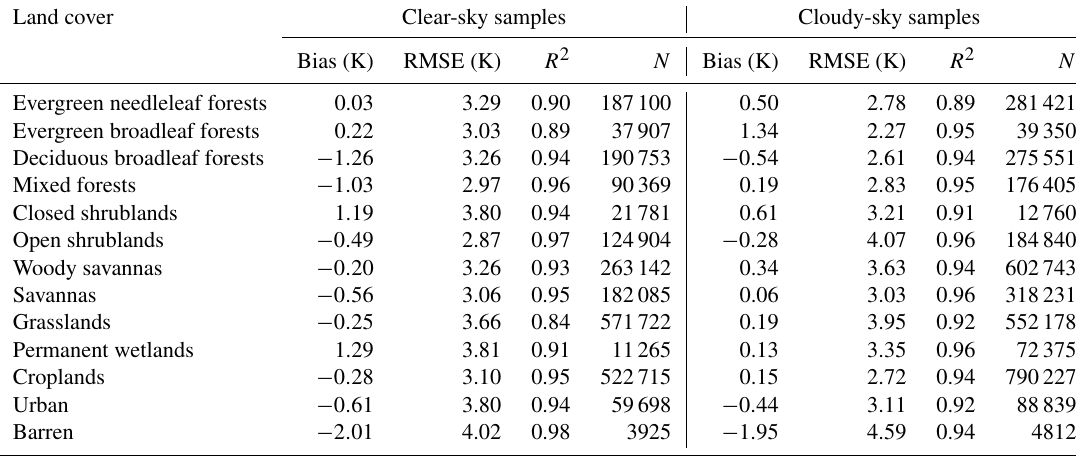
Table 3. Validation statistics for different land cover types. Land cover Clear-sky samples Cloudy-sky samples